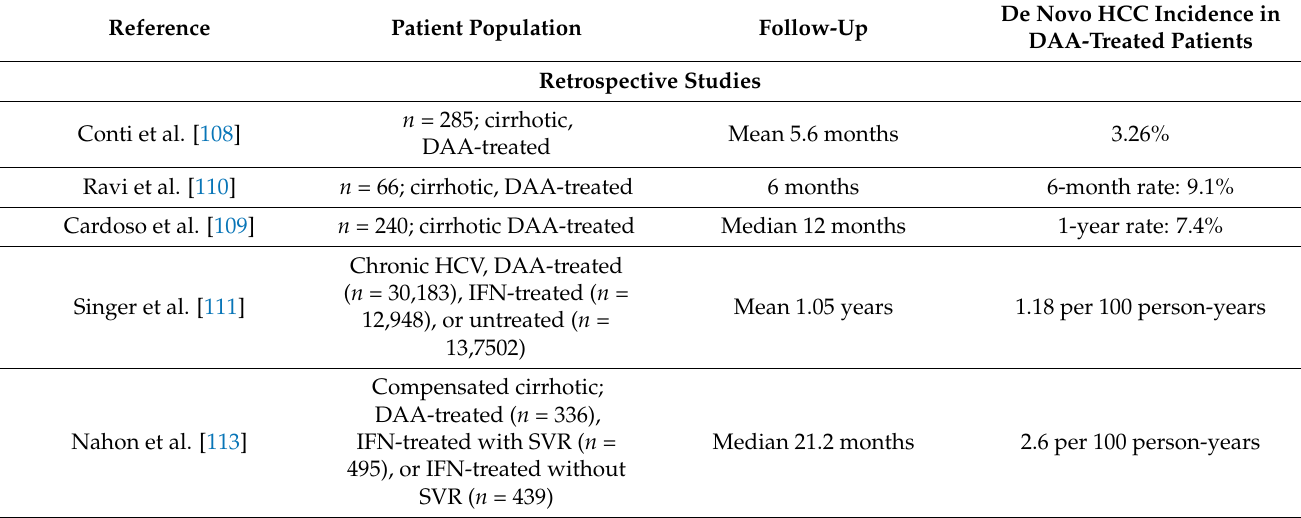
Table 2. Selection of retrospective and prospective studies evaluating the incidence of de novo HCC in DAA-treated HCV patients (adapted from Muzica et al.)